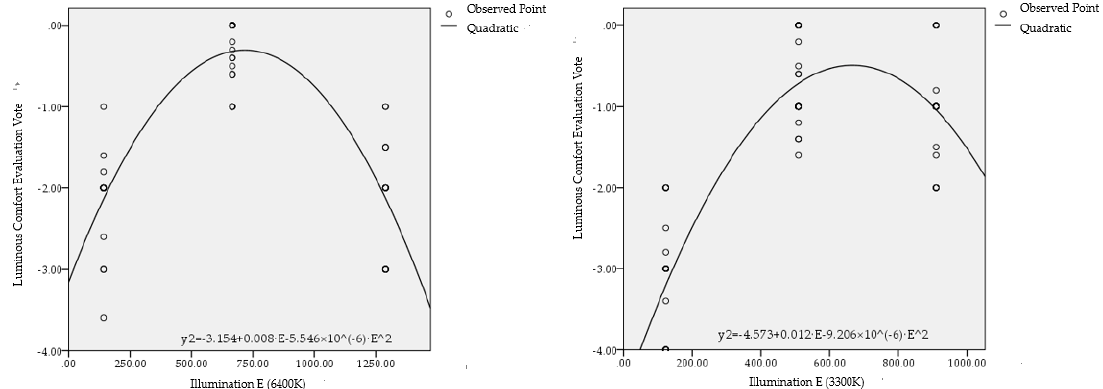
Figure 6. Luminous comfort evaluation vote.